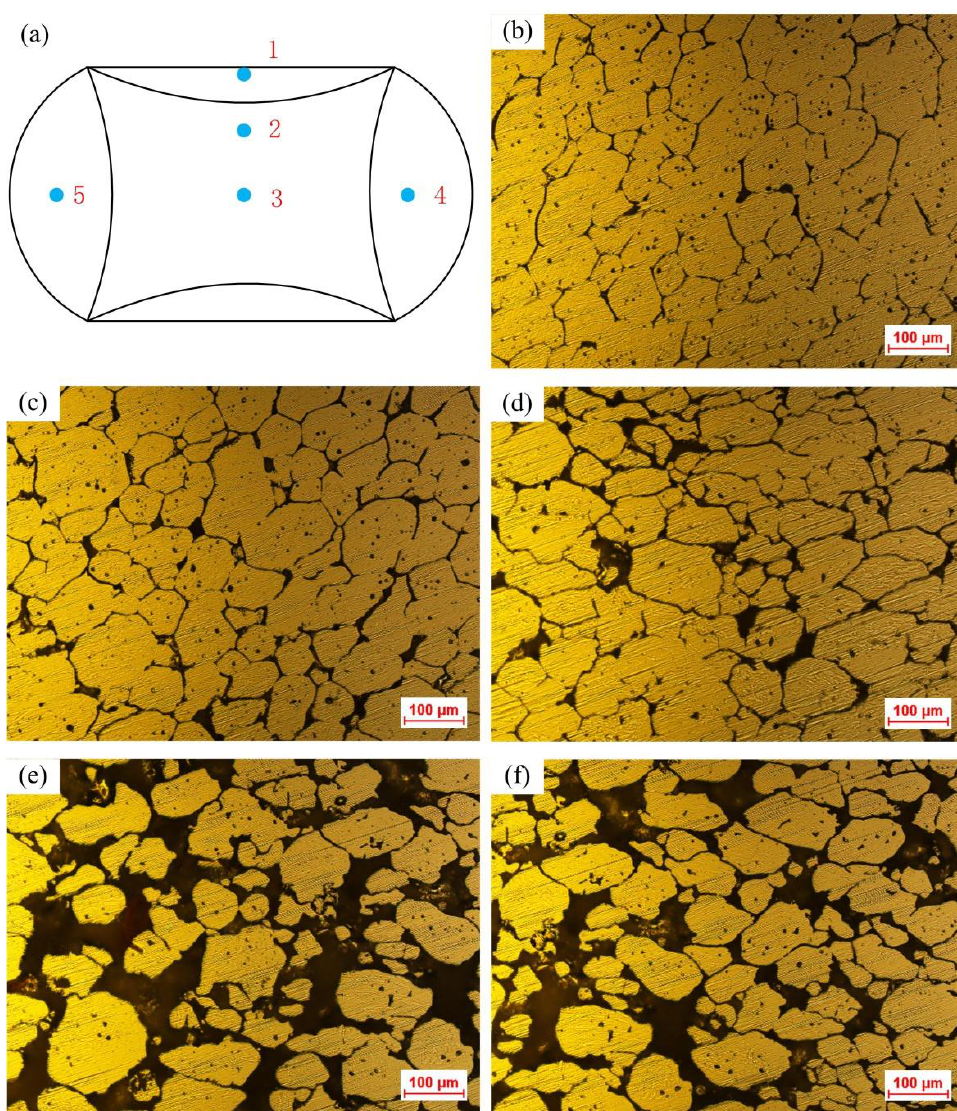
Figure 12. Microstructures of the cold radial forged 6063 alloy processed by SSIC (deformation temperature: 630 °C, strain rate: 0.1 s −1 ): ( a ) Sample positions, ( b ) Position 1 in Region A, ( c ) Position 2 in Region B, ( d ) Position 3 in Region B, ( e )Position 4 in Region C, and ( f ) Position 5 in Region C.